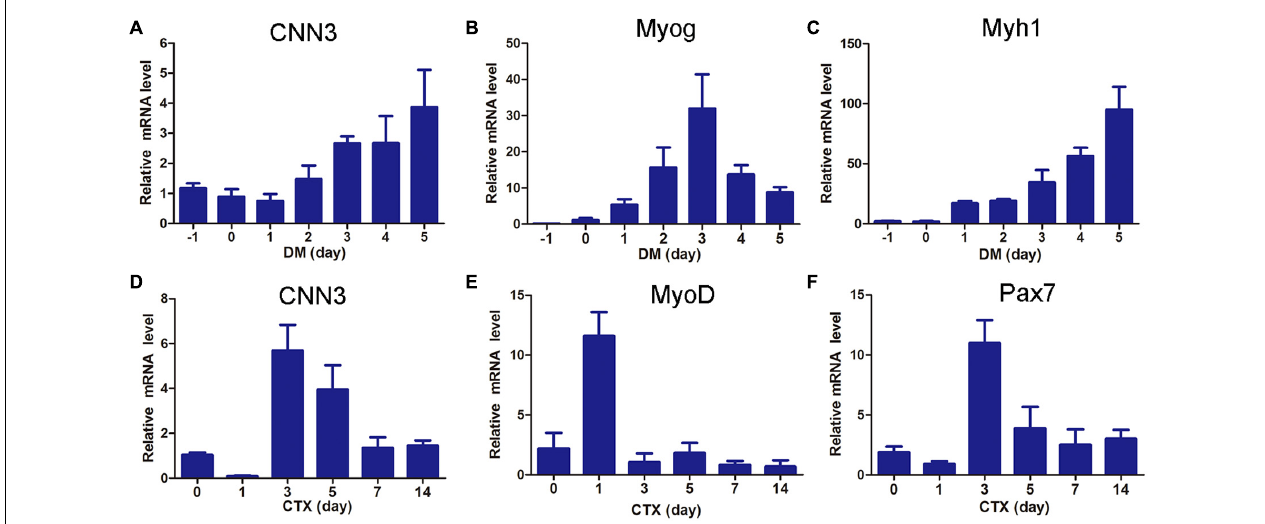
FIGURE 1 | CNN3 was upregulated during myogenesis and muscle regeneration. (A–C) qRT-PCR results showing the expression patterns of (A) CNN3, (B) Myog, and (C) Myh1 during myoblast differentiation. (D–F) Hindlimb muscles were injected with cardiotoxin (CTX) and Tibialis anterior (TA) muscles were harvested at 0, 1, 3, 5, 7, and 14 days post-injury for (D) CNN3, (E) MyoD, and (F) Pax7 mRNA